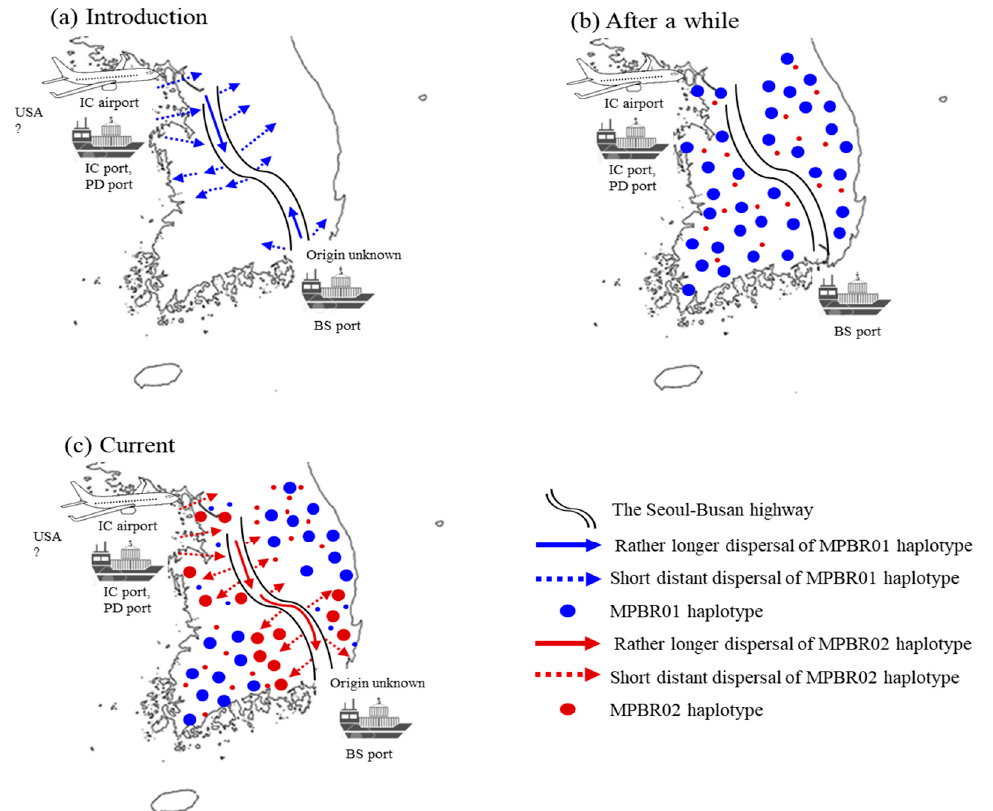
Figure 7. Scenarios of potential points of entry and expansion routes of Metcalfa pruinosa in Korea. ( a ) The initial introduction of M. pruinosa possessing one dominant haplotype (MPBR01) through port(s) and/or the airport located in the North-West region and Busan port located in the South-East region, and subsequent expansion primarily through the Seoul − Busan highway. ( b ) Eventual widespread distribution of MPBR01 occurs over all of Korea. ( c ) Introduction of M. pruinosa possessing another dominant haplotype (MPBR02) through port(s) and/or the airport located in the North-West region and widespread primarily in the North-West and South − East regions, but not yet to other locations. Incheon (IC), Pyeongtaek − Dangjin (PD), and Busan (BS).